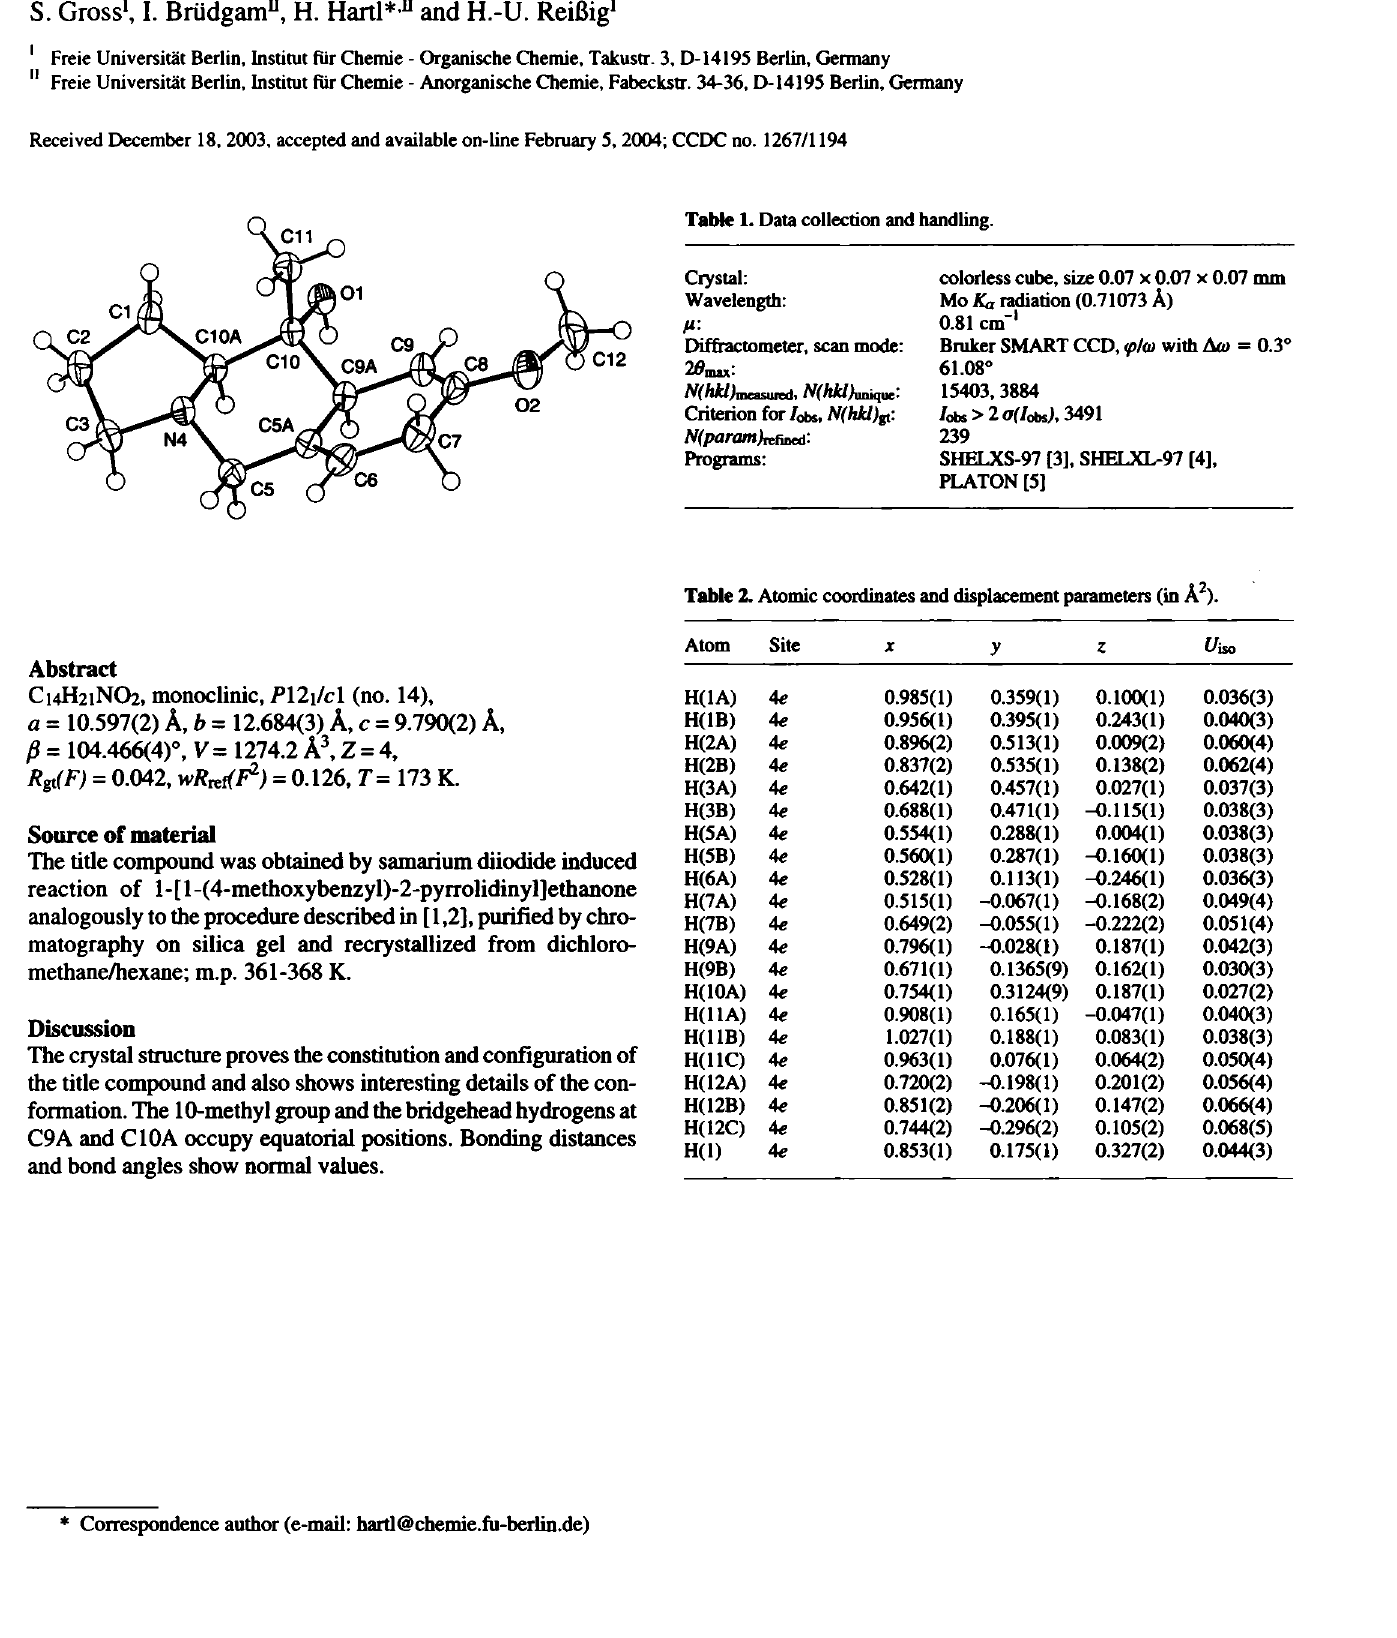
Table 1. Data collection and handling.